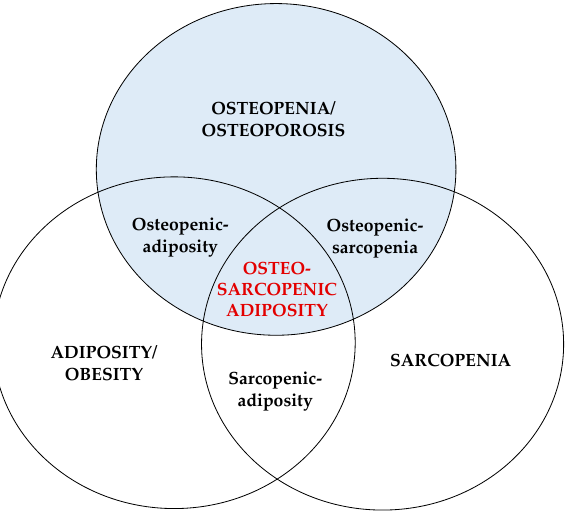
Figure 1. Osteosarcopenic adiposity/obesity and its components. Adapted from Ilich et al. [1].